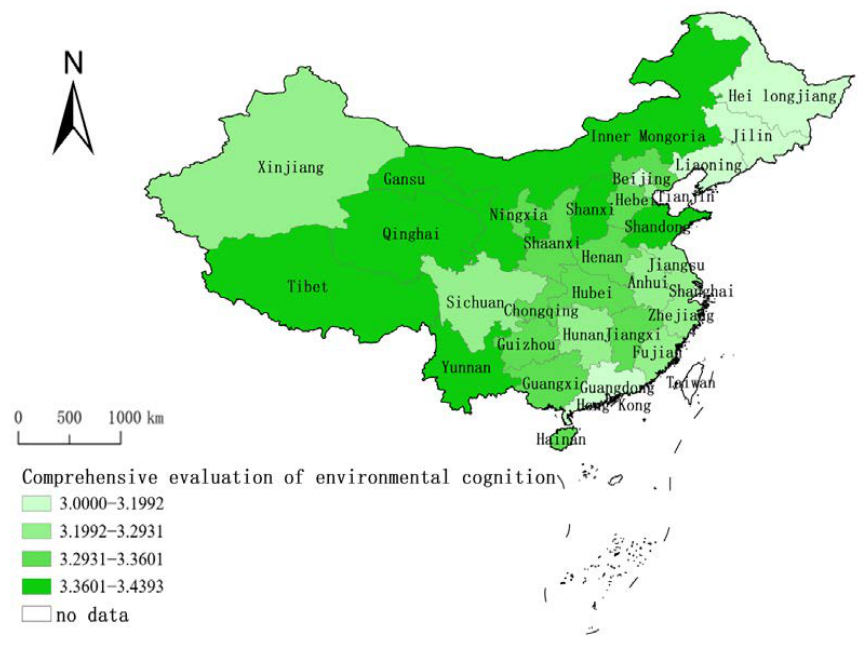
On the whole, the spatial distribution pattern of environmental cognition was low in the northeast and high in the northwest.